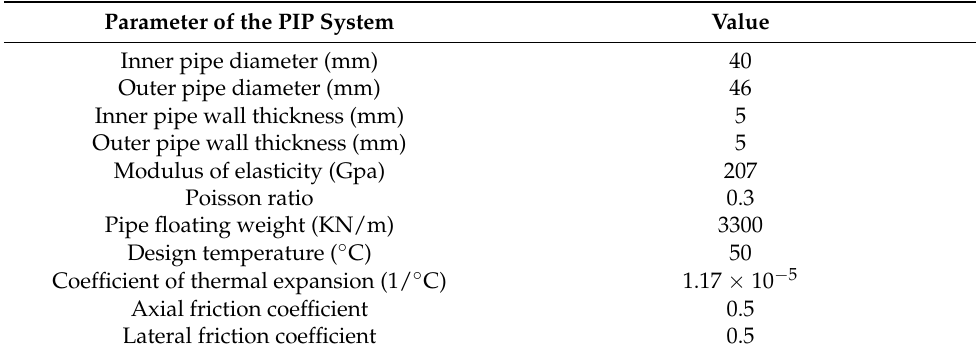
Table 9. Parameters of the PIP